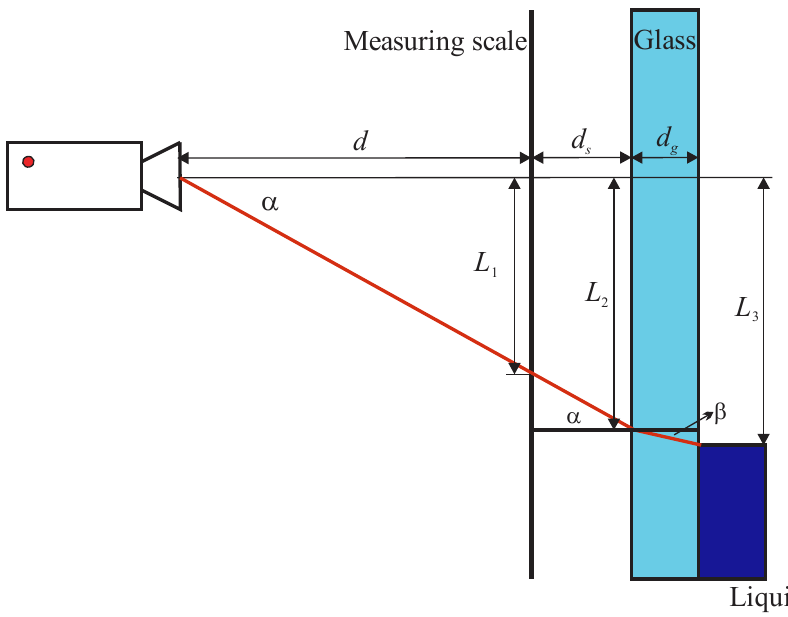
Figure 1. Scheme of the parallax effect.